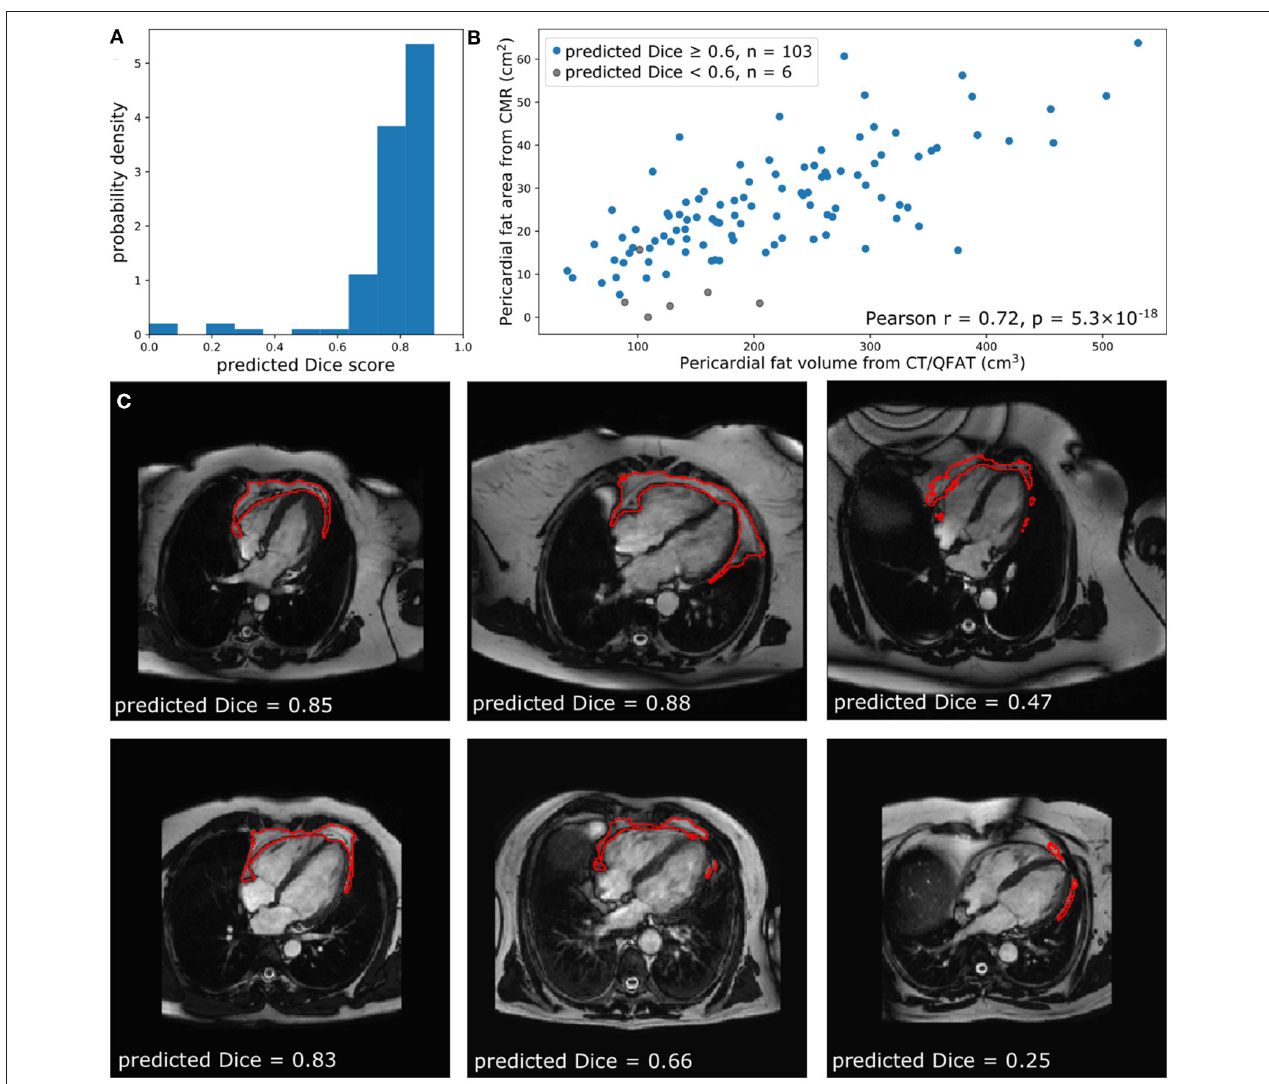
FIGURE 4 | Comparison of quantified PAT from CT and CMR. (A) The predicted Dice scores of the segmented data. (B) Correlation between PAT volume quantified via QFAT software and PAT area quantified using our method. Subjects with a predicted Dice < 0.6 were excluded from Pearson analysis. (C) Some example CMR images, their automatically segmented PAT, and the predicted segmentation quality are also shown for